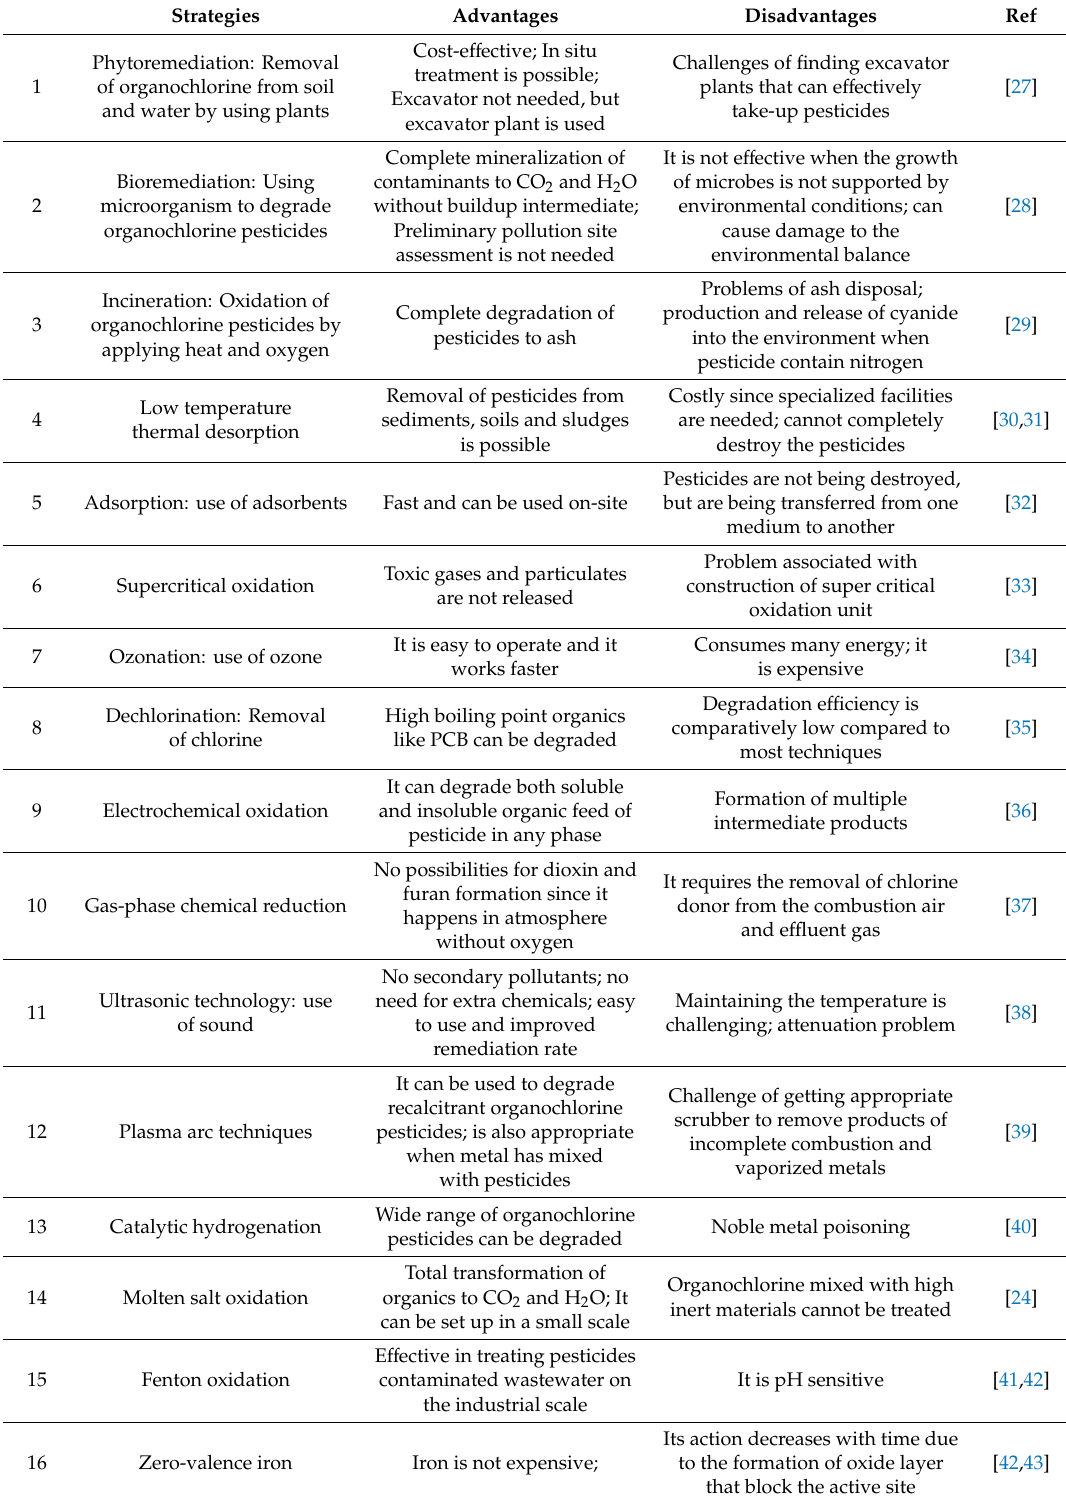
Table 1. Pesticides removal strategies with their advantages and